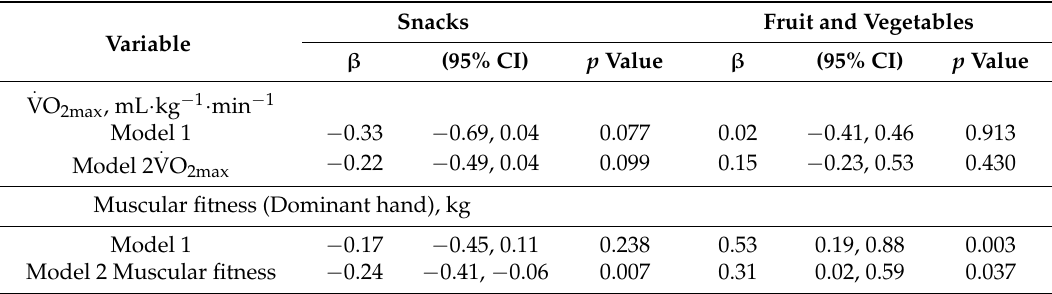
. Model 1: adjusted for age and sex. Model 2 VO 2max : Model 1 + ethnicity, NZDep13, FFMI, FMI, height, and moderate-vigorous physical activity. Model 2 Muscular fitness: Model 1 + ethnicity, NZDep13, FFMI, . height, and moderate-vigorous physical activity. β represents the mean difference in VO 2max (mL · kg − 1 · min − 1 ) or muscular fitness (kg) associated with a unit higher in standardized dietary pattern score. CRF, cardiorespiratory . fitness; VO 2max , maximal oxygen uptake; FFMI, fat-free mass index; FMI, fat mass index; NZDep13, New Zealand deprivation index